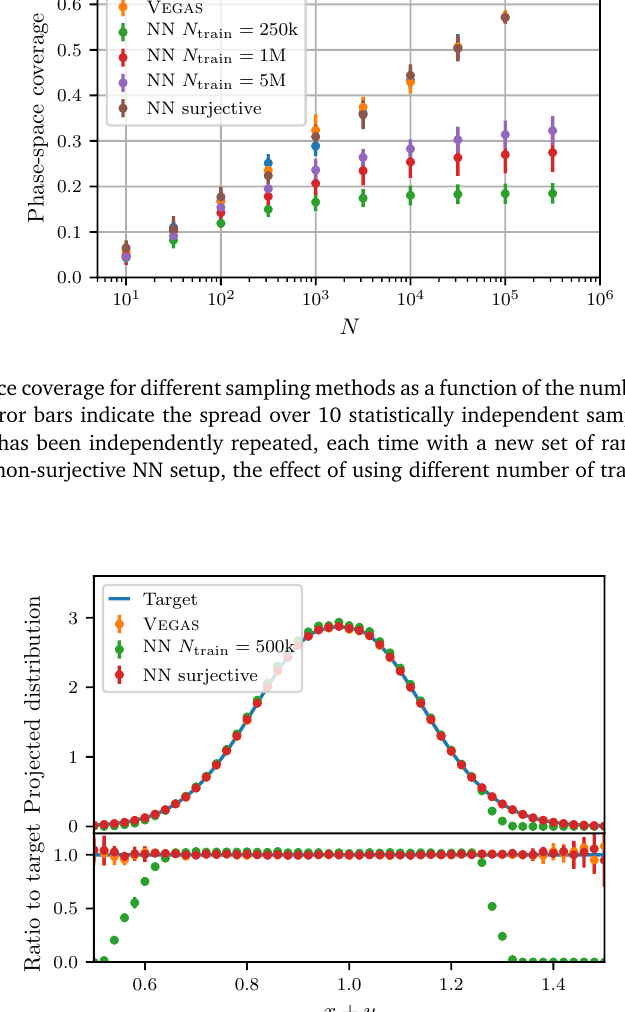
(b) The two-dimensional distribution of sampling points averaged over bins with x + y = const., com- pared to the corresponding average of the target distribution. Figure 1: The phase space coverage and the distribution averaged over diagonals of the two-dimensional plane for different sampling techniques, with the target distri- bution being a two-dimensional Gaussian centred in ( 0,1 ) 2 . The Gaussian width is σ = 0.1. Besides the Uniform and the V EGAS samples we also show NN-generated samples. The NN architecture is described in the main text, it uses sigmoids as acti- = 500k. The input space is given by ( 0,1 ) 2 . vation and output functions, and N train The “surjective” NN on the other hand only uses surjective functions and the input space is